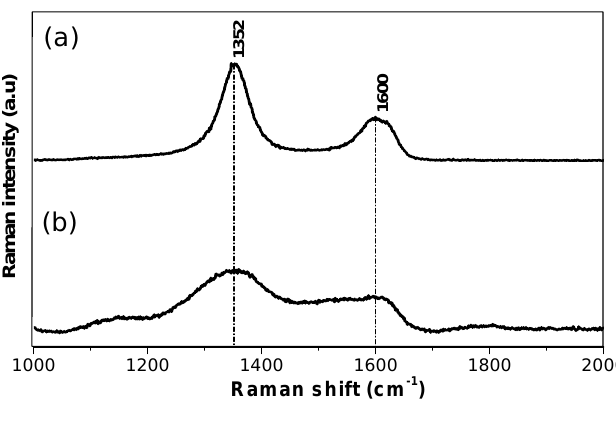
Figure 3. First order Raman spectra of heat treated at 1,850 °C ( a ) in comparison to the as-pyrolysed (1,050 °C) BC N ceramic ( b ). 2